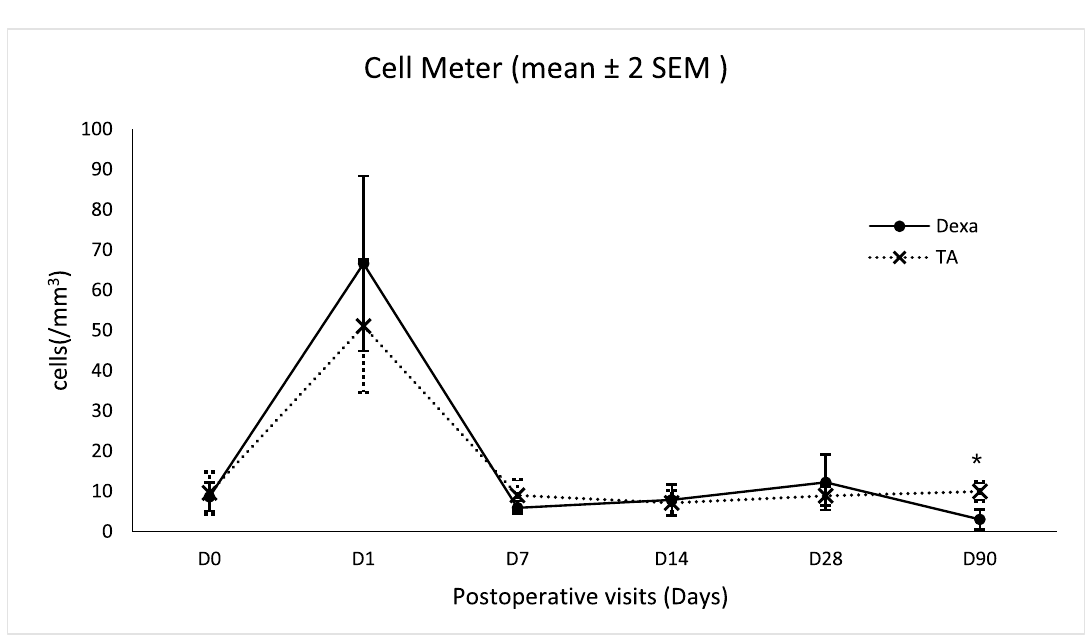
Figure 3. Mean anterior chamber cell ± 2 SEM (/mm 3 ) from laser flare-cell meter at each study visit. The mean cells of Dexa group were significantly lower than TA group at post operative day 90 (mean difference −6.93; 95% CI −10.34, −3.52; * p <